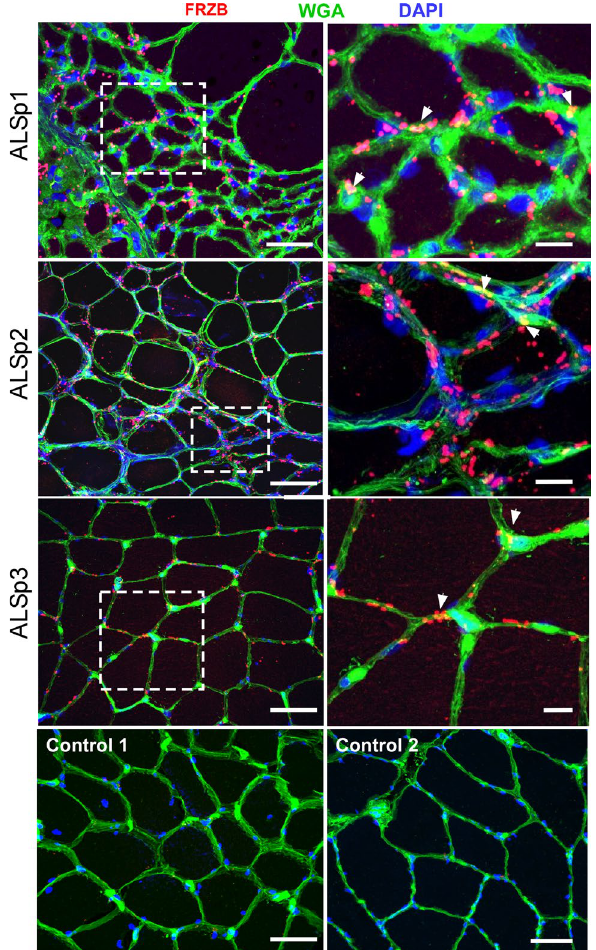
Figure 3. FRZB is upregulated in ALS myofibers. Immunohistochemistry of FRZB in vastus lateralis muscle in three ALS and two normal control subjects is shown. FRZB staining is punctate in appearance around the periphery of myofibers. Enlarged photomicrographs of boxed areas in the ALS sections are shown in the panels on the right. Arrowheads show areas of merged FRZB/WGA signal. No immunoreactivity is seen in two normal control muscle samples (bottom panels). Scale bars, 50 µM in low power views and 10 µM in the enlarged